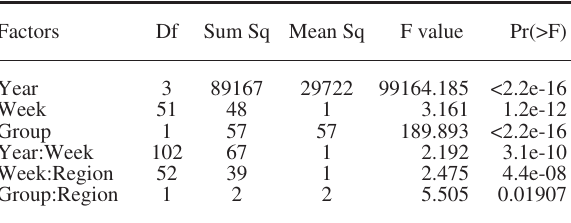
Table 4. – results from the lPue standardisation model. df, de- grees of freedom. Factors